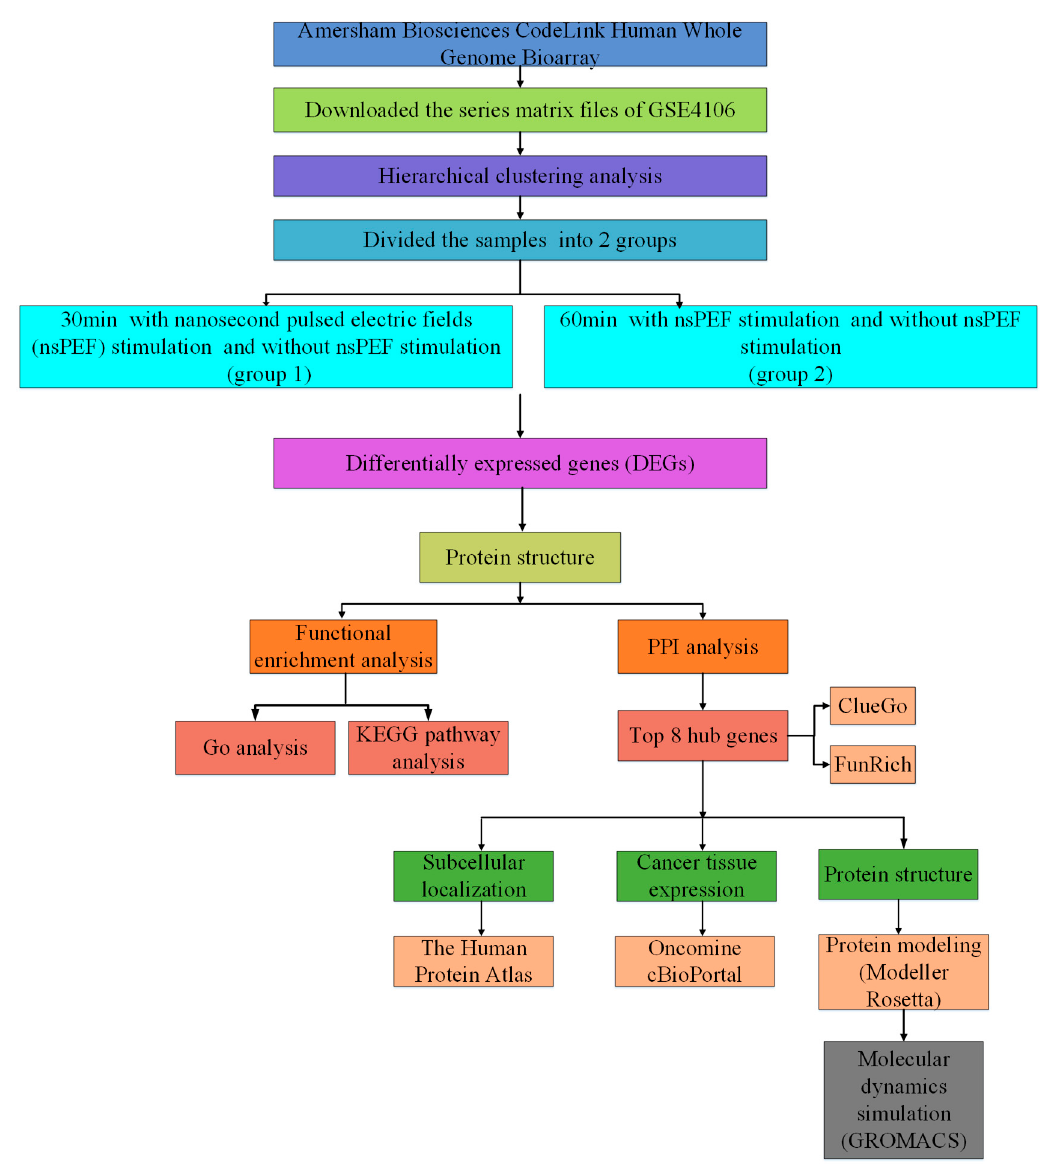
Figure 1. Schematic overview of the workflow.